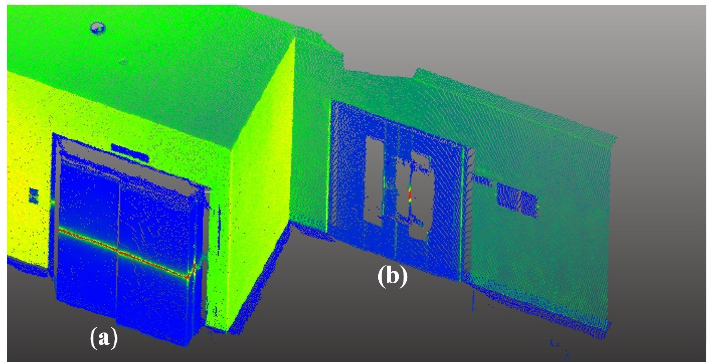
Figure 3. Two types of doors: ( a ) non-coplanar doors, ( b ) coplanar doors. Firstly, vertical planes were fitted to the point cloud data obtained at each scanner station using RANSAC [26]. Afterwards, the point cloud data representing the vertical planes with a height less than 0.9 times the room height were classified as potential non- coplanar doors and removed. This was found to be an effective and efficient means of removing non-coplanar doors.